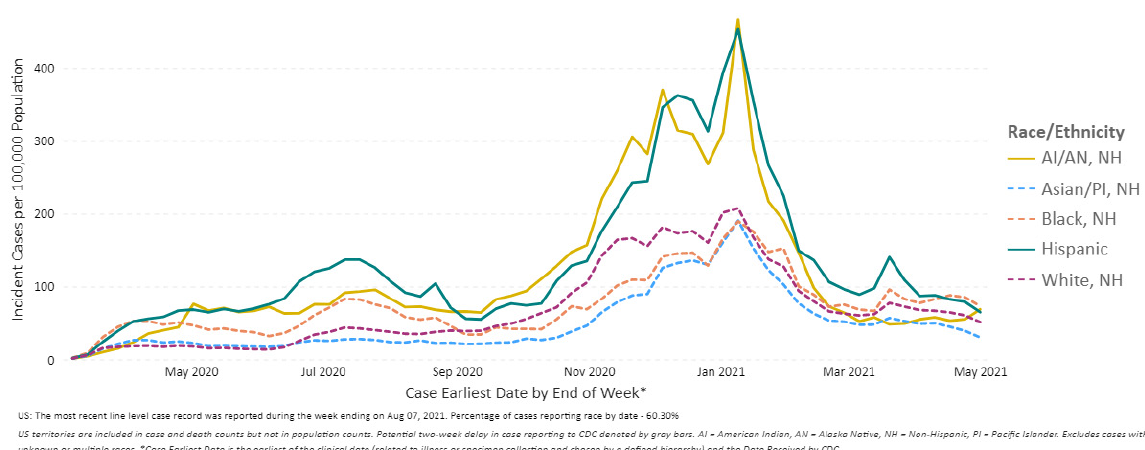
Figure 6. COVID-19 Weekly Cases per 100,000 Population by Race/Ethnicity, United States between 1 March 2020 and 1 May 2021 (Source: Reproduced from the CDC) [4].